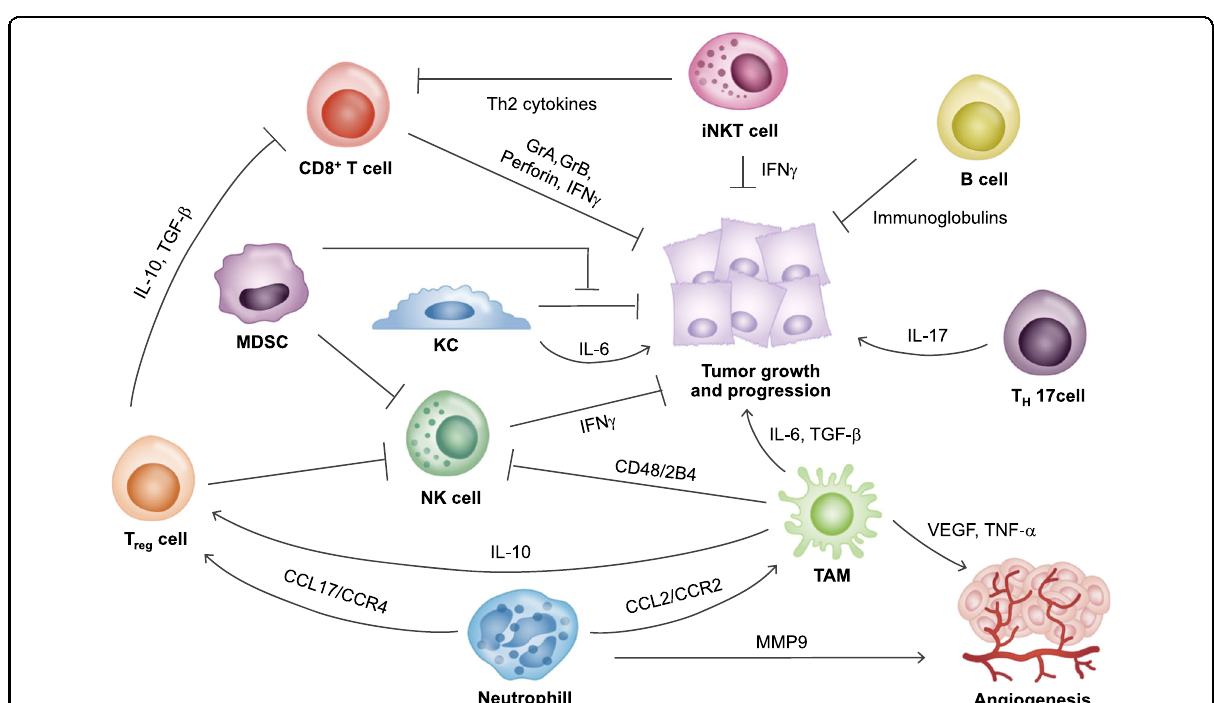
Fig. 2 The immunological microenvironment of hepatocellular carcinoma. In the HCC liver microenvironment, a large population of immune cells, Th17 cells, Tregs, iNKT cells, TAMs, and neutrophils are activated. However, immune cells with antitumor functions such as NK cells, CD8 + T cells, and KCs are mostly defective. The number of NK cells is decreased, and their function is suppressed by Tregs and MDSCs. KCs have dual roles in the tumor microenvironment. These cells secrete IL-6 to promote tumor development. KCs also have antitumor functions. However, the antitumor function of KCs is suppressed by MDSCs. CD8 + T cells can directly inhibit tumor growth by secreting granular components and cytokines. However, these cells are suppressed by Tregs in the HCC microenvironment. TAMs play various roles during HCC progression, including affecting angiogenesis. Neutrophils can also induce angiogenesis while attracting protumorigenic cells, such as TAMs and Tregs. These immune cells play various roles and can exacerbate HCC development by supporting tumor growth, progression, and